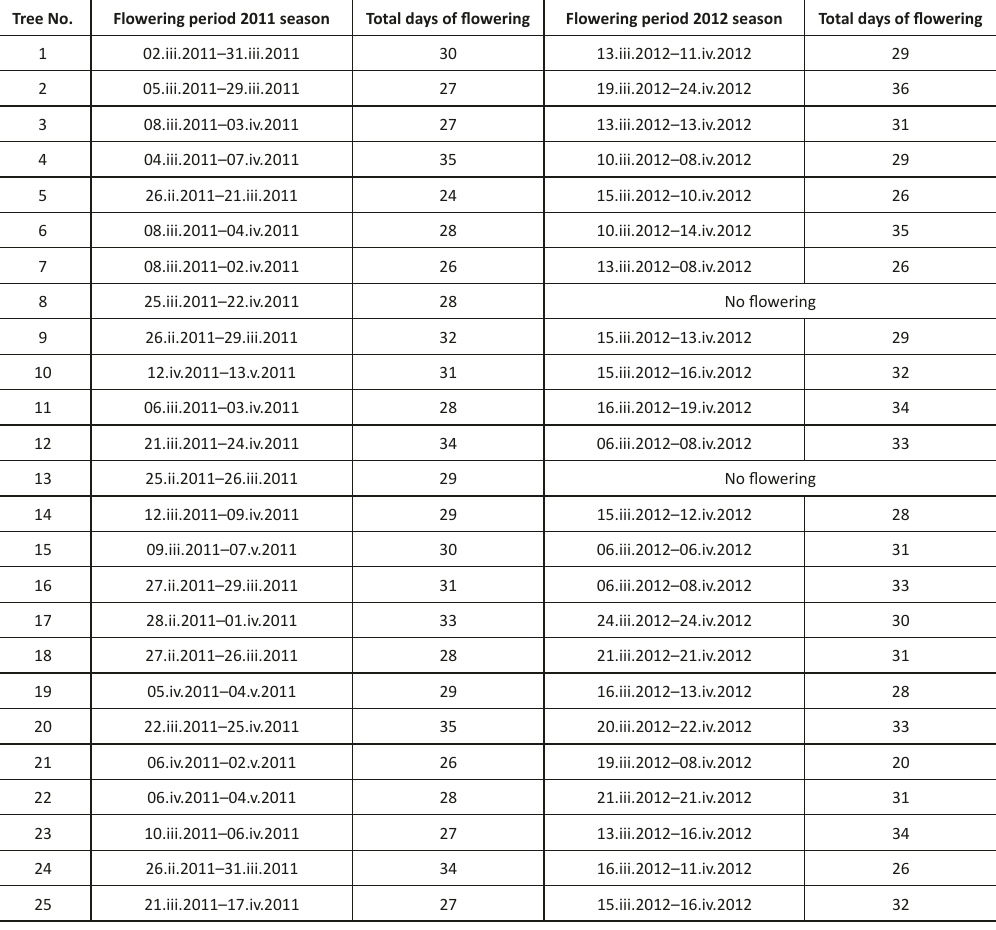
Table 1. Flowering phenology of Hildegardia populifolia Tree